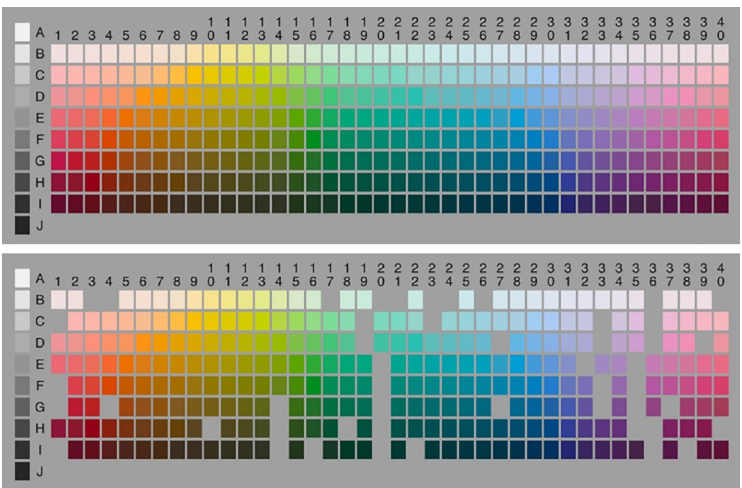
Fig 1. The 280 color samples used in the current study (upper panel) when listed according to the color sample palette used in the WCS (lower panel). The color samples were displayed on three cards for the survey (shown in Fig 2).